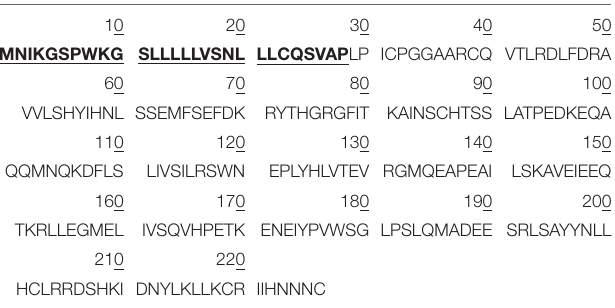
TABLE 1 | The amino acid sequence of hPRL prohormone (Swiss-Prot No.: P01236; position 1–227; 227 amino acids long, and 25.9 kDa), and mature PRL (position 29-227; 199 amino acids long, 22.9 kDa).